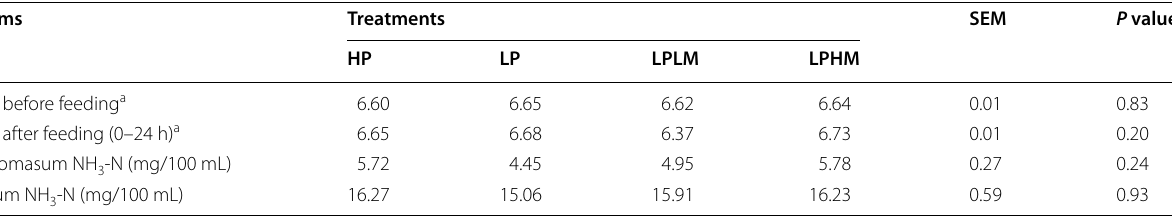
SEM standard error of the mean a,b Superscripts values within the same row, are significantly different at ( P < 0.05) Table 4 Effects of rumen-protected methionine supplementation with low dietary protein on the post-ruminal produc- tion of NH -N and Rusitec pH using a rumen simulation technique and in vitro digestibility technique (means; n 3